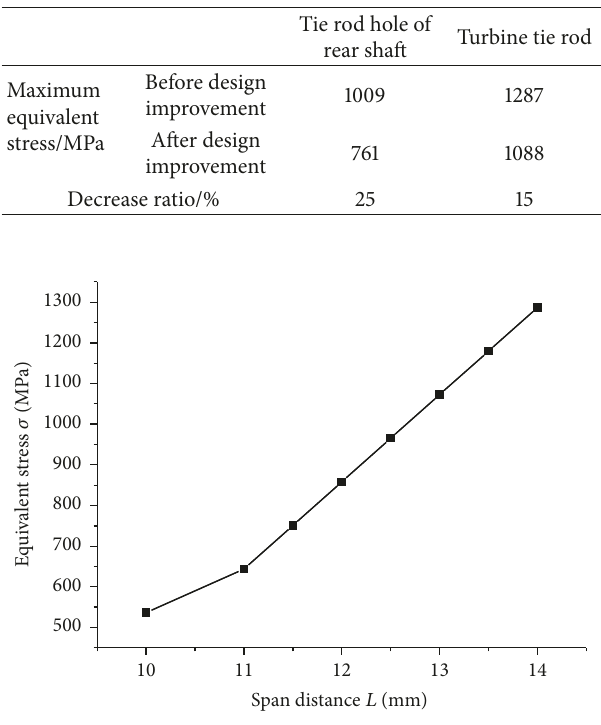
Figure 25: The results under different span